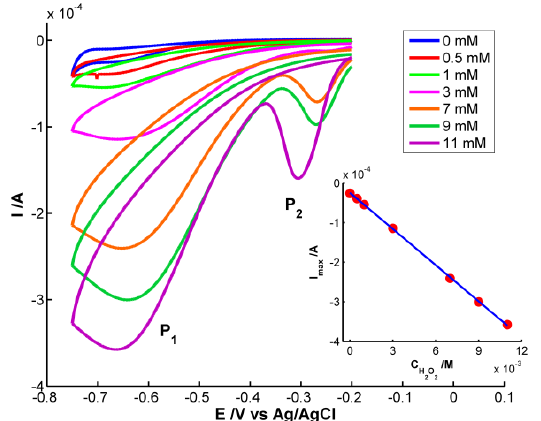
Figure 5. Voltammetric response of AgNPs-modified SPE when H was added to buffer solution (pH = 7). Scan rate: 0.05 V·s −1 ; E E = −0.75 V (inset: calibration curve where current intensity at P vertex H O concentration) 2 2